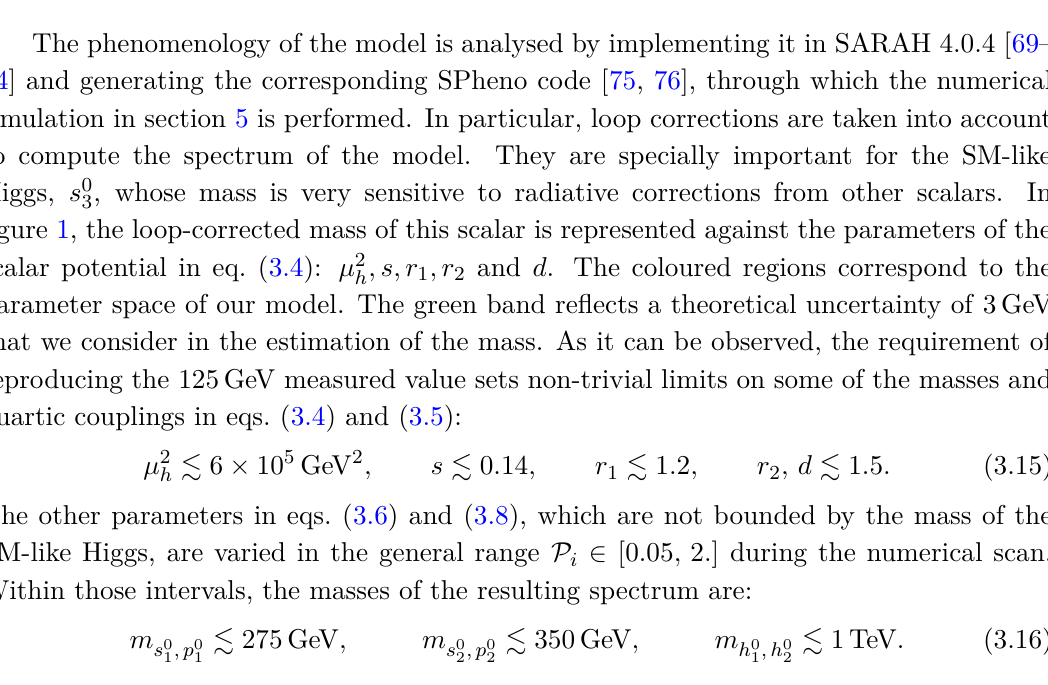
Figure 1 . Loop corrected masses versus the parameters of the scalar potential in eq. (3.4): µ 2 (Left) and P i = s, r 1 , r 2 , d (Right). The rectangular green band corresponds to the allowed values of the 125 GeV SM like Higgs boson; an uncertainty of 3 GeV is assumed in the numerical computation of the Higgs